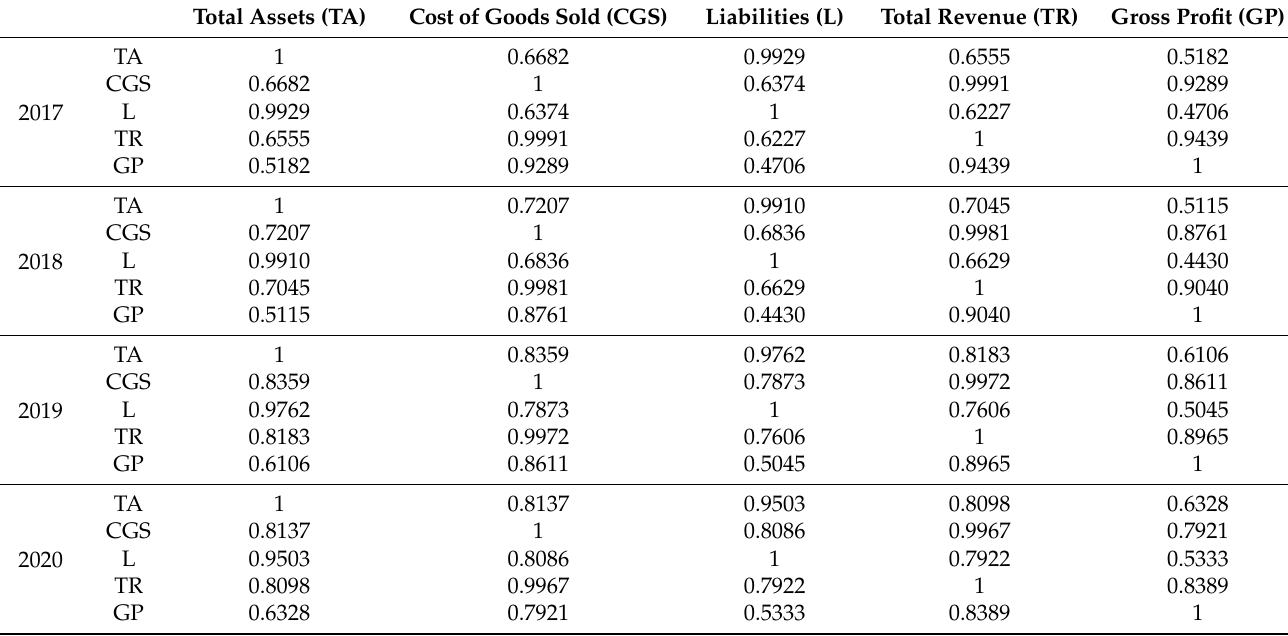
Table 6. Pearson correlation coefficients from